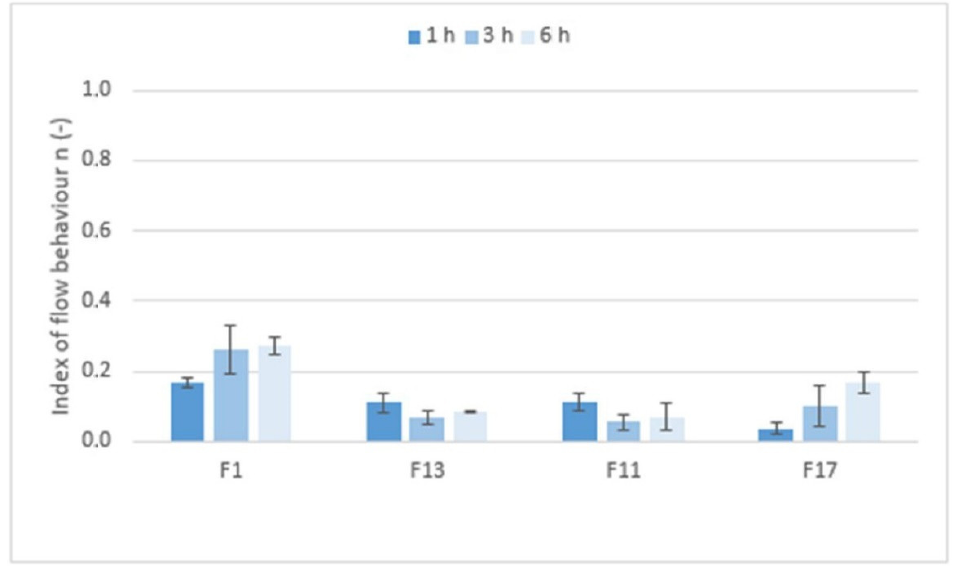
Figure 9. The values of the index of flow behavior n ( − ) for matrix tablets F1, F11, F13, and F17. Table 3. The values of complex modulus G *, elastic modulus G (cid:48) , and viscous modulus G (cid:48)(cid:48) a phase angle δ for matrix tablets F1, F11, F13, and